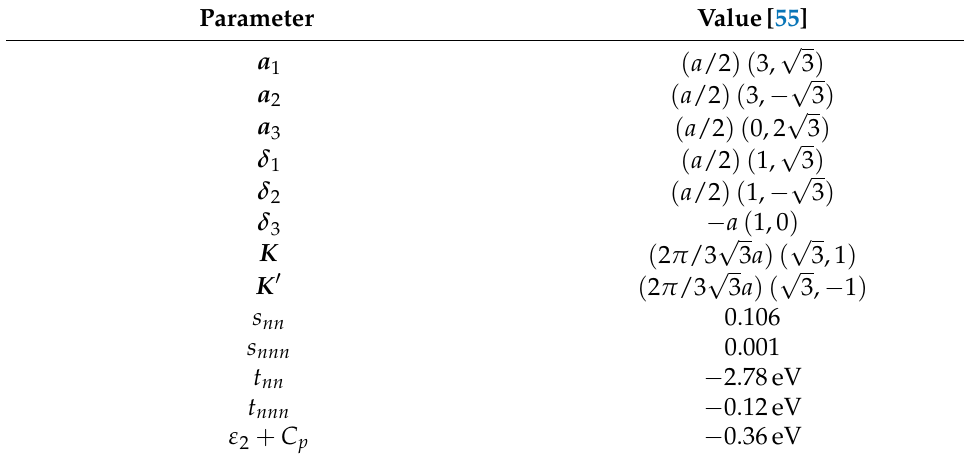
Table 3. Graphene structure and tight-binding model parameters.